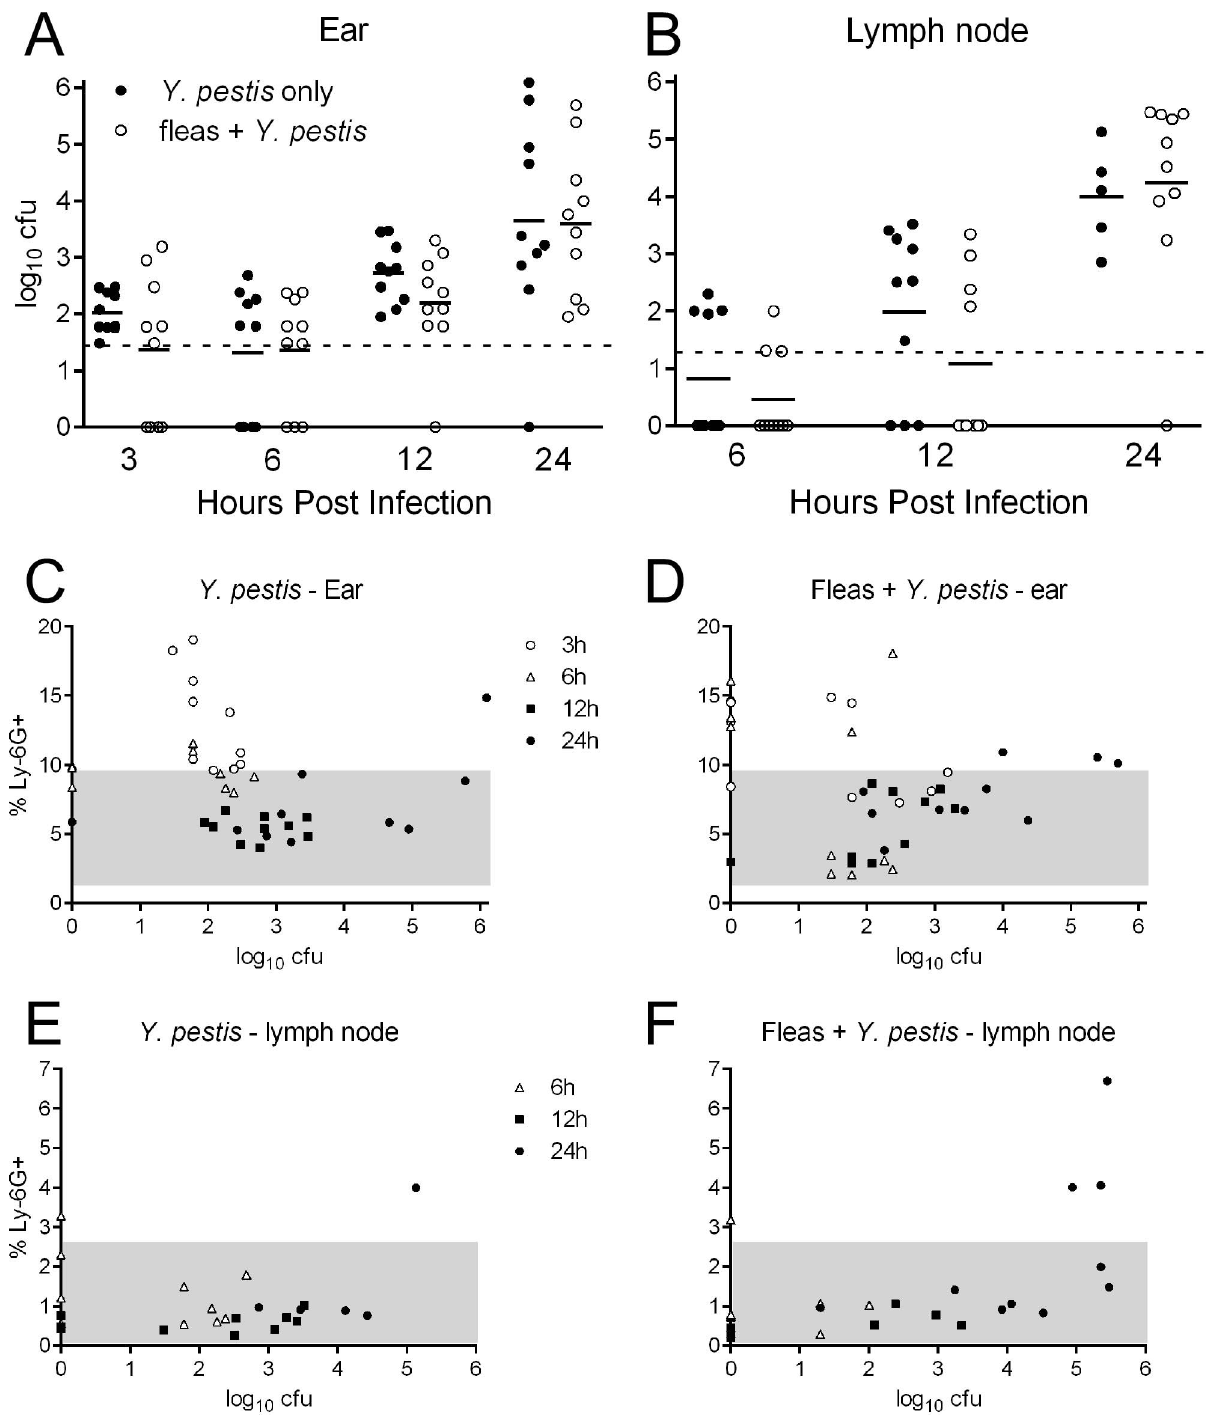
Figure 2. Injection of Y.pestis at a flea feeding site does not affect bacterial survival or dissemination kinetics in naı¨ve mice. Mice were infected intradermally in the ear with , 250 CFU Y. pestis , with or without prior flea feeding at the injection site. Bacterial load in the ear ( A ) and draining superficial parotid lymph node ( B ) were not significantly different at any timepoint after infection. Horizontal black lines indicate mean CFU per group; dashed lines indicate the lower limit of detection of the assay. A general lack of correlation between bacterial load and neutrophils recruited in the ear ( C, D ) and lymph node ( E, F ) was seen for both the Y. pestis -only ( C, E ) and fleas + Y. pestis ( D, F ) mouse groups. The shaded areas represent the range of % neutrophils obtained from the PBS injected controls. Each symbol represents an individual mouse. Data are pooled from two independent experiments per timepoint.